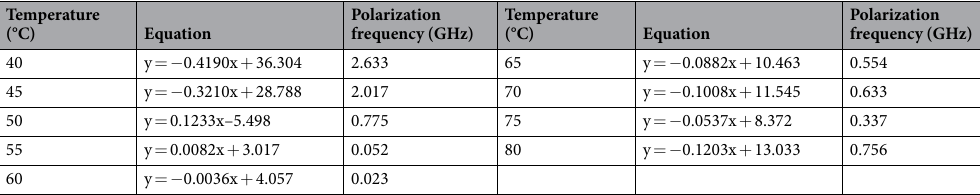
Table 2. The fitting equations of Cole-Cole curves and polarization frequency for starch–water mixtures treated using rapid conventional heating.